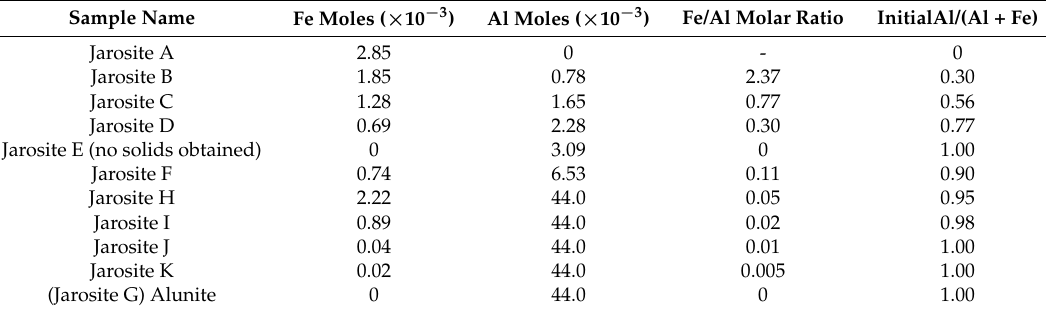
Table 1. List of all samples prepared and the initial molar ratios used to obtain the solids.